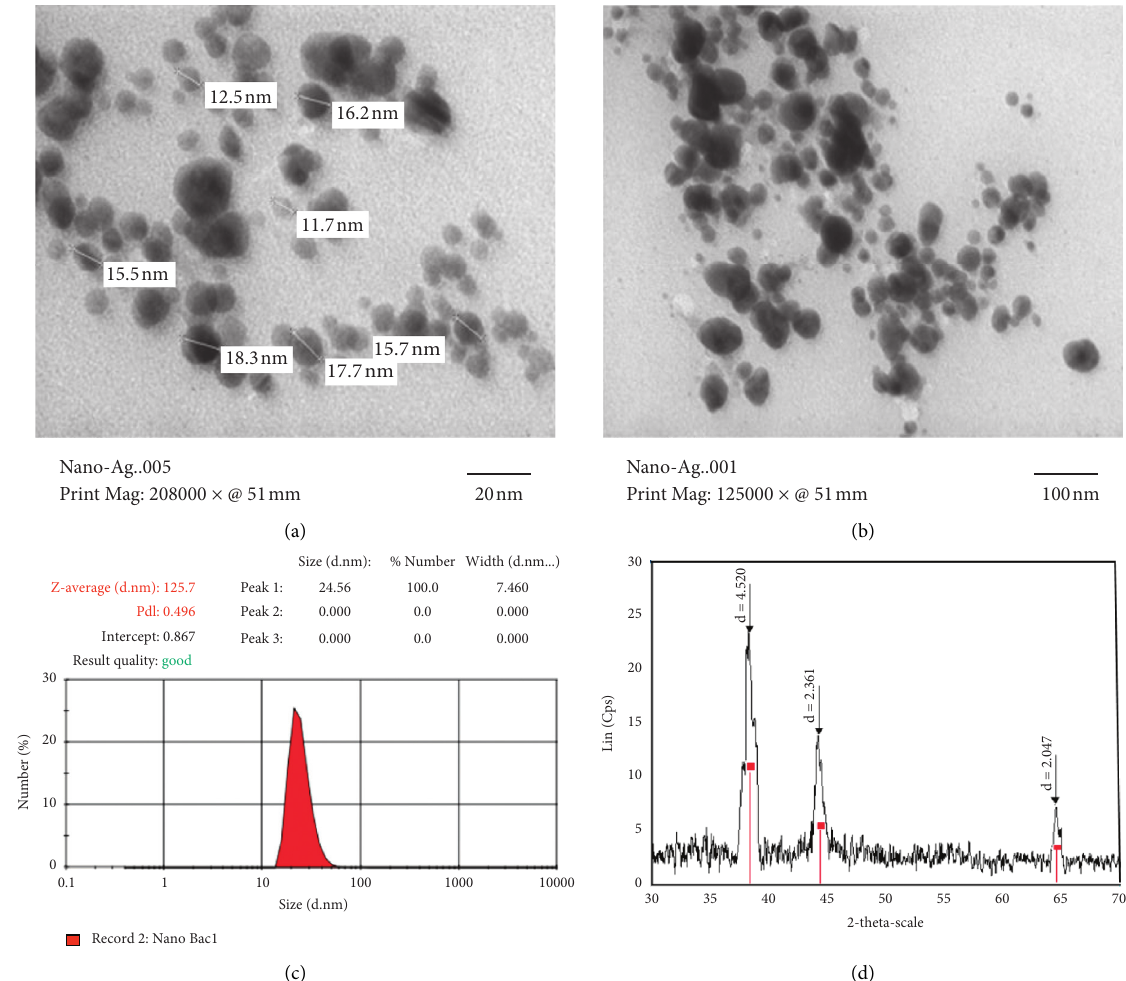
Figure 7: (a, b) TEM images, (c) size distribution by zeta potential measurement, and (d) XRD patterns of silver nanoparticles synthesized from 0.01M AgNO 3 solution and 7mL of Centella asiatica (L.) Urban